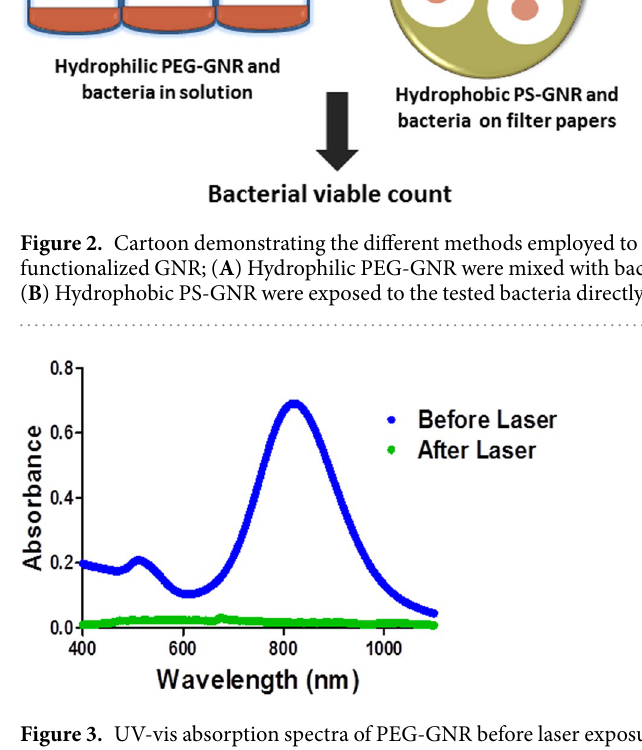
Figure 3. UV-vis absorption spectra of PEG-GNR before laser exposure (blue line) and after 20 min of laser exposure (green line) where a complete loss of the typical optical properties of GNR was